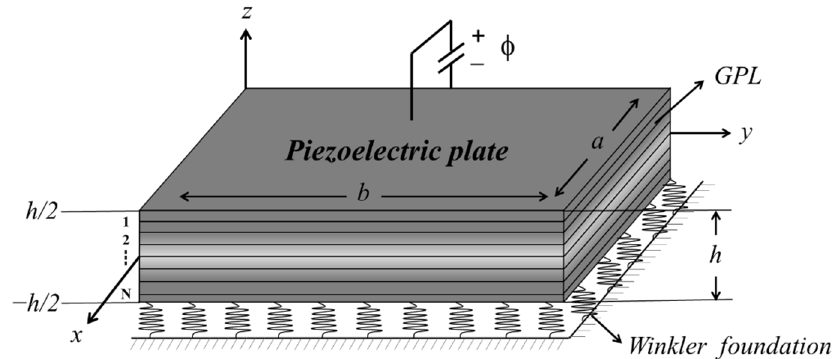
Figure 1. AN FG-GRP plate resting on the Winkler elastic foundation is shown. In this research, three graphene distribution patterns are generated by smoothly varying the graphene volume fractions along the thickness direction, as shown in Figure 2: denoted as the U type, the X type, and the O type. The graphene volume fraction of the top and bottom surfaces is significantly larger than that of the mid-plane in the X type, indicating that the reinforcing effect of GPL in the top and bottom surfaces is more remarkable than that in the mid-plane. On the contrary, the graphene volume fraction of the top and bottom surfaces is significantly lower than that in the mid-plane in the O type, indicating that GPL reinforcements have opposite strengthening effects for both the O type and X type. The graphene volume fraction maintains constant along the thickness direction for the U type, resulting in a uniform distribution on the whole. Both the X and O types are functionally gradient distributions in which the graphene volume fraction increases or decreases linearly and symmetrically from the mid-plane to the top and bottom surfaces of the composite.